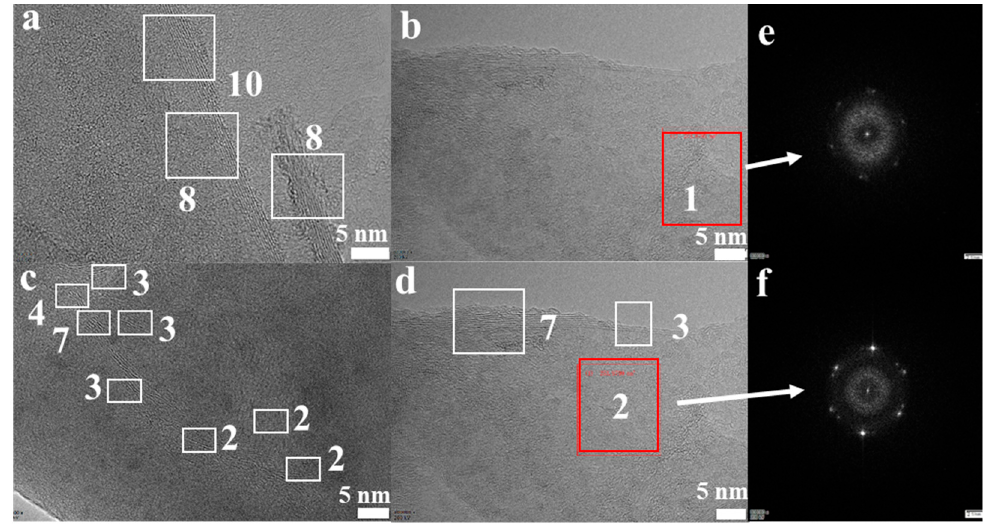
Figure 3. ( a – d ) High-resolution transmission electron microscopy (HRTEM) images of the FLG nanosheets; ( e – f ) the images of the measured electron diffraction pattern.